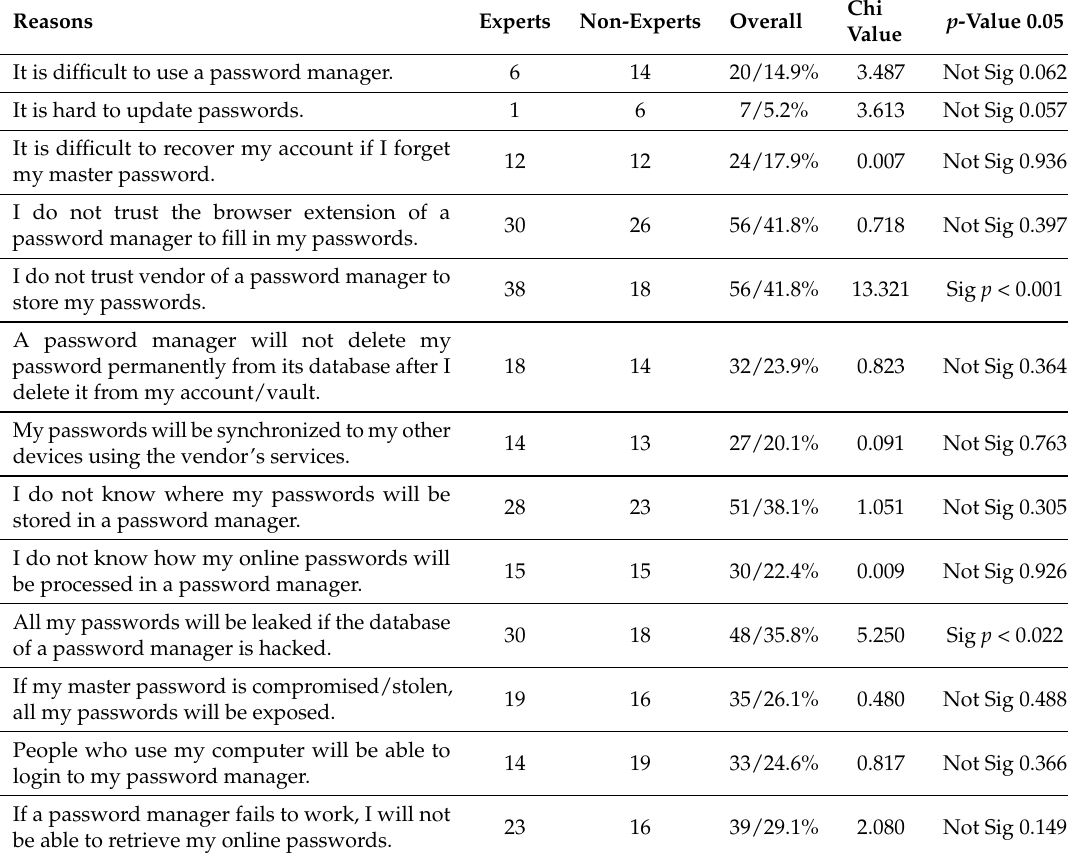
Table 20. Number of times each reason was selected by 66 experts and 68 non-experts, which also means these reasons were not selected by the remaining experts and non-experts. The table shows the overall time and percentage of reasons selected by both groups. A Pearson Chi-Square test was used to check for a significant difference between 66 experts and 68 non-experts for not using a password manager, it shows a Pearson Chi-Square value and a p -value for each reason selected/not selected by both